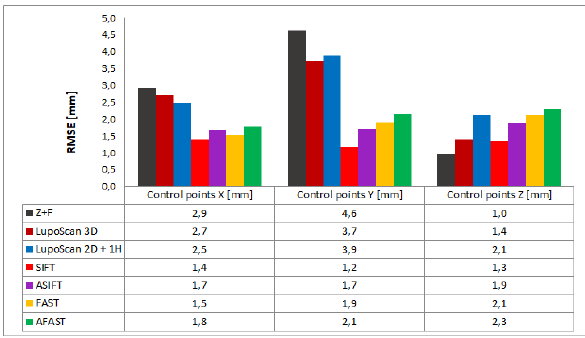
Figure 6. The quality assessment of exterior orientation – RSME on marked control points